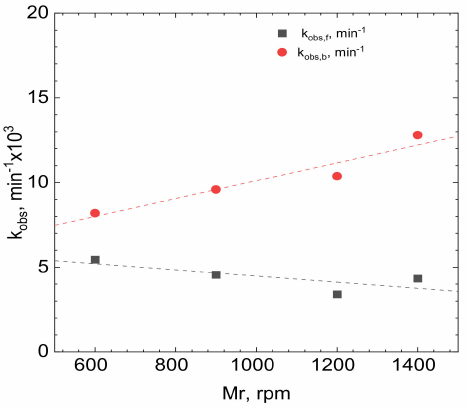
Figure 11. The influence of the stirring rate on the observed rate constants. Experimental